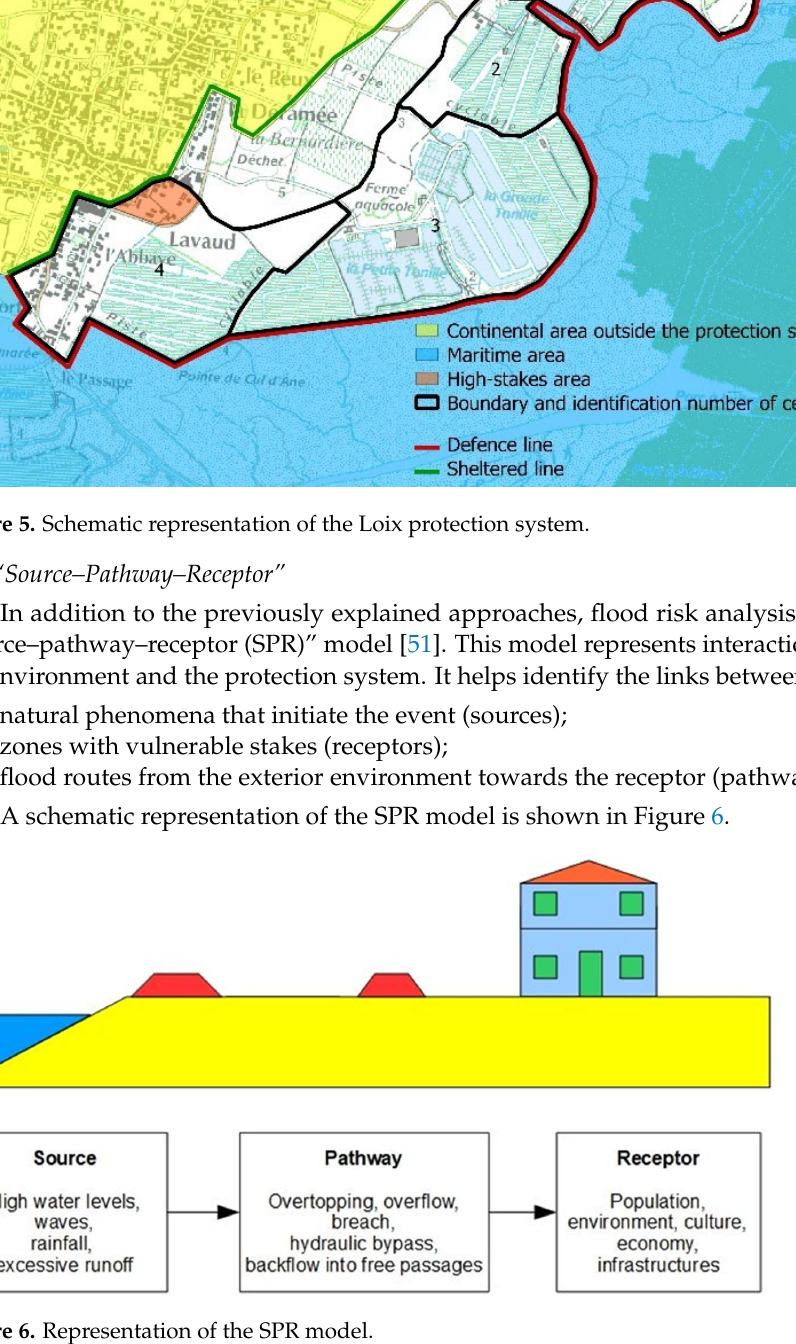
Figure 4. Synthetic topographic map. Altitudes are given using the NGF/IGN69 (French reference system).